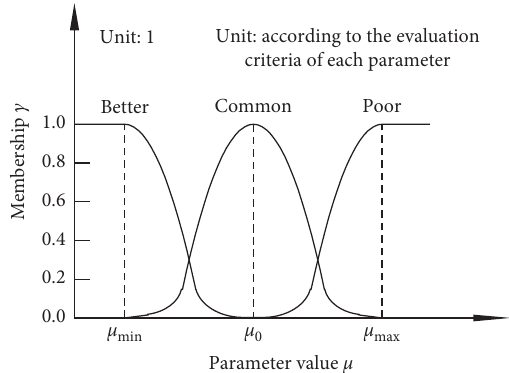
Figure 2: Model of membership in the fuzzy normal distribution.